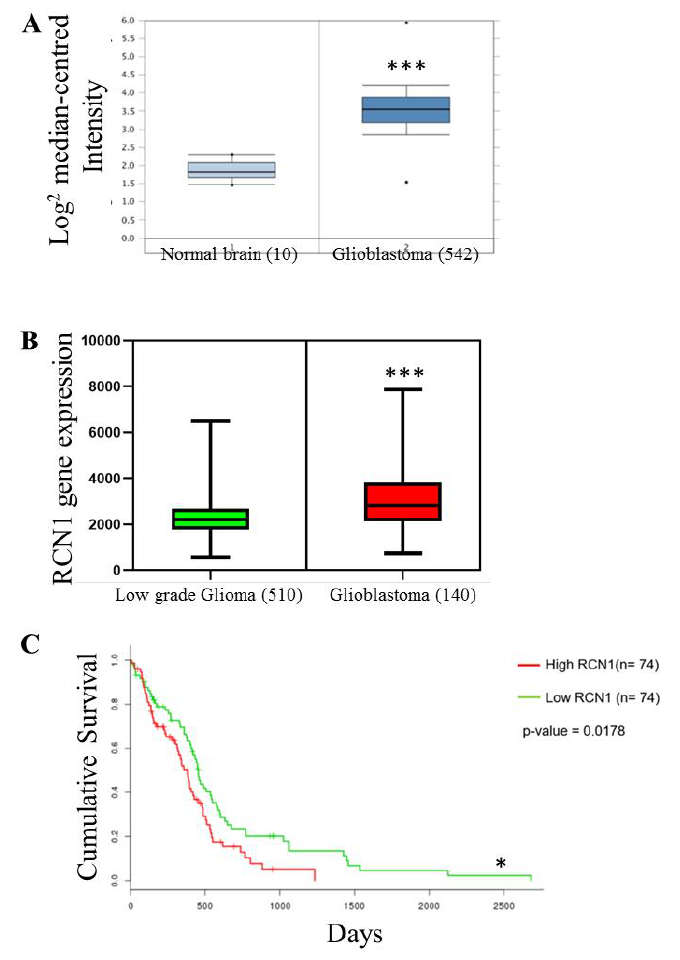
Figure 1. RCN1 expression correlates with glioma grade and poorer survival in glioblastoma patients. ( A ) Data set obtained from Oncomine (https://www.oncomine.org, access date 26 April 2018) showed that RCN1 gene expression is 3.22 times higher in glioblastoma patient tumor tissue ( n = 542) compared to normal brain tissue ( n = 10). The y-axis indicates the log2 median mRNA levels. ( B ) Box-plot comparison analysis performed with TCGA data available in OncoLnc (http://www.oncolnc.org/, access date 26 April 2018) at 50:50 upper and lower percentile, and indicated reduced RCN1 mRNA levels in low grade glioma ( n = 510) compared to glioblastoma ( n = 140). ( C ) The relationship between high (Red) and low (Green) RCN1 gene expression with patient survival was determined through mining a SurvExpress TCGA dataset. Kaplan–Meier survival curves were evaluated from the TCGA, n = 148. * p < 0.05; *** p <